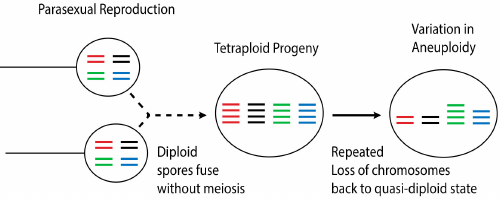
Figure 3. Parasexuality is a process of reproducing without a reductive cell division (meiosis). With parasexuality, a tetraploid o ff spring is produced, which is a transient stage followed by random loss of chromosomes during vegetative